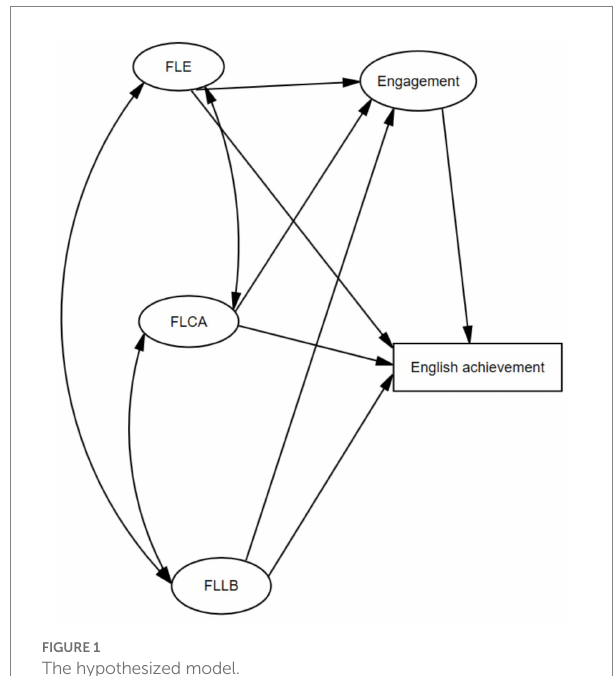
FIGURE 1 The hypothesized